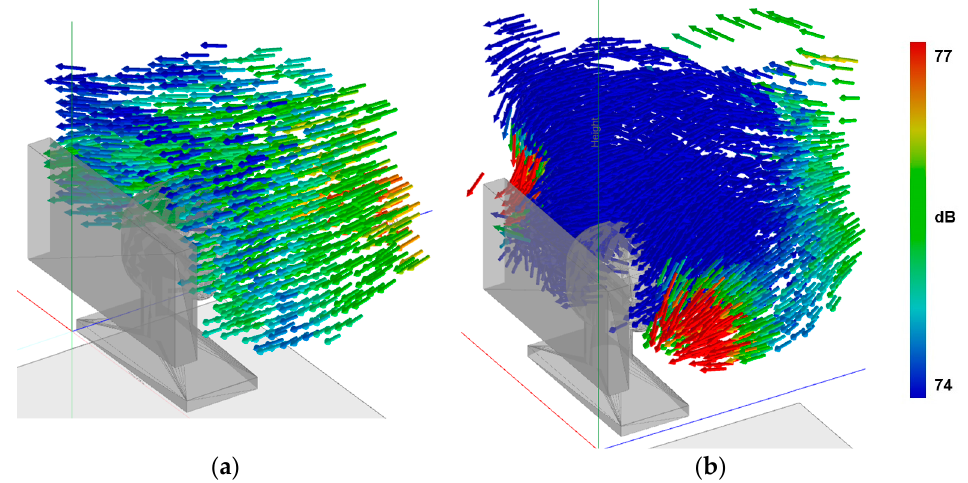
Figure 9. Sound intensity (W/m 2 ) measured with and without ANC at left and right mics. ( a ) Sound